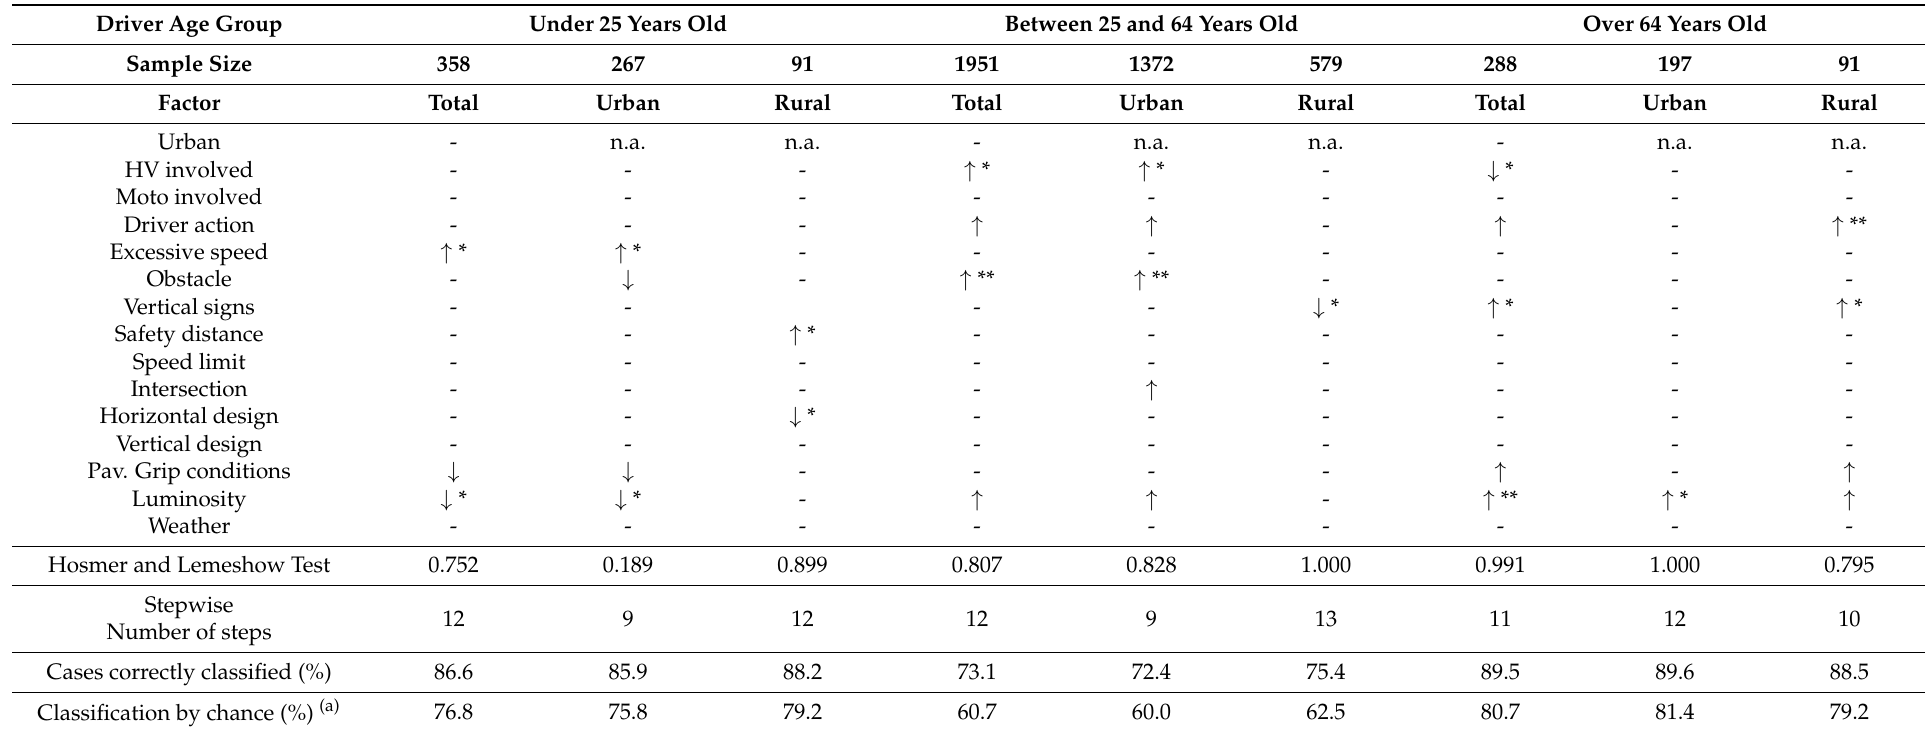
Table 8. Summary of model qualitative findings for driver age